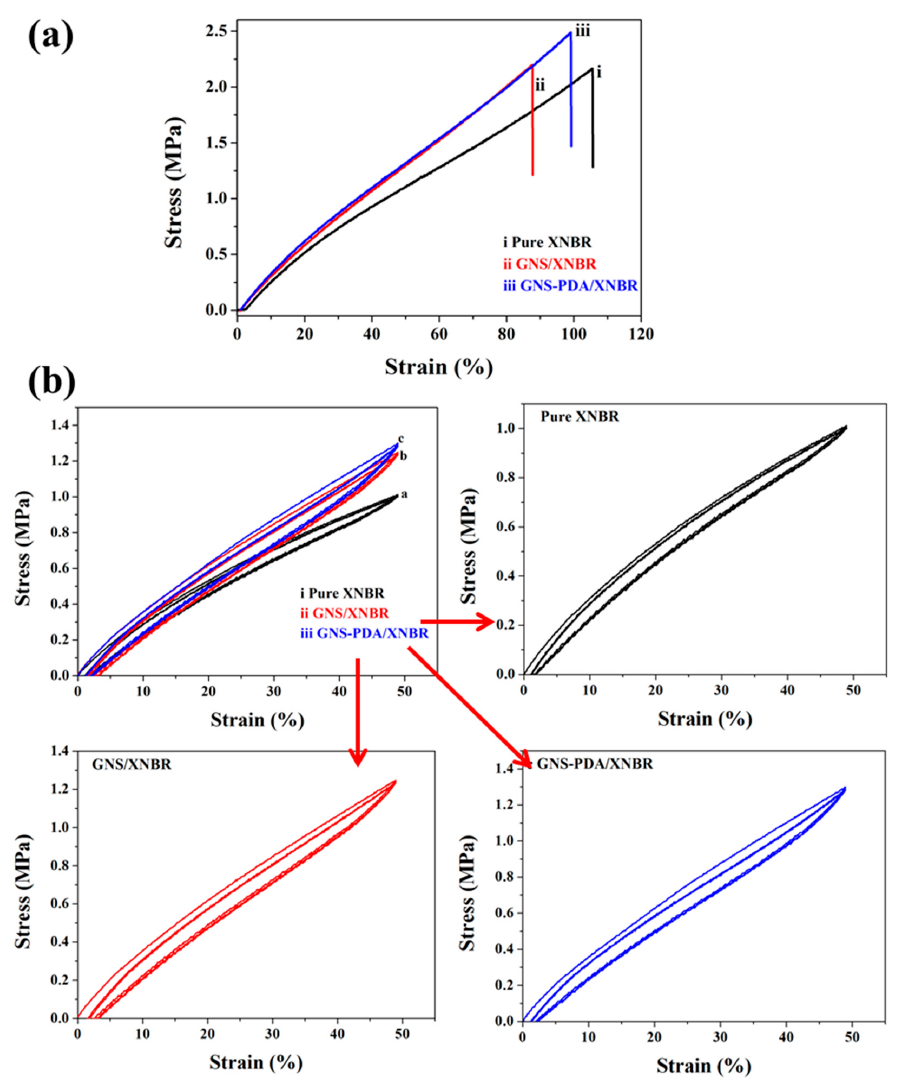
Figure 5. ( a ) Stress-strain curves and ( b ) cyclic stress-strain curves at 50% strain of pure XNBR, GNS/XNBR composite, and GNS-PDA/XNBR composite.